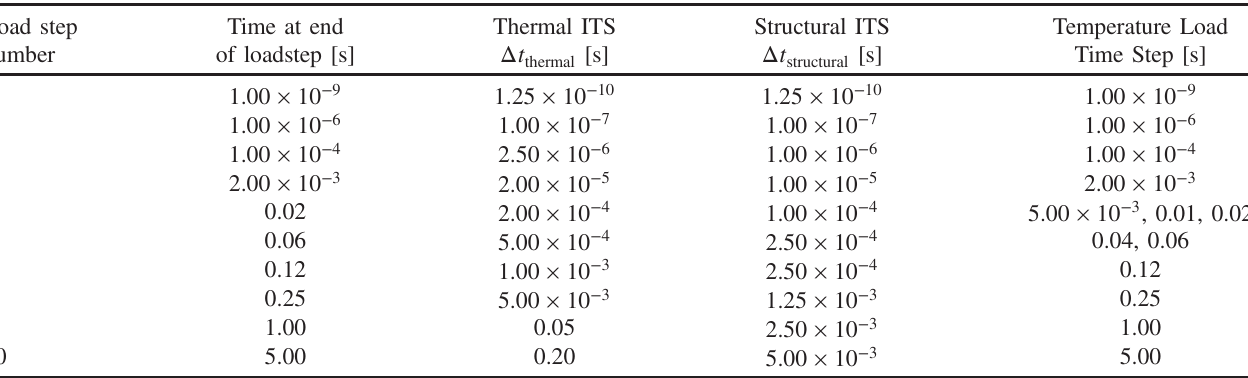
TABLE III. Load step sequences used for the FEM thermal and structural analyses. The first load step represents the beam impact. The computational time needed to achieve complete transient thermal and structural solutions was ∼ 1 day and ∼ 4 weeks per solution respectively on a 32 GB RAM 4-core machine with a processor speed of 4.0